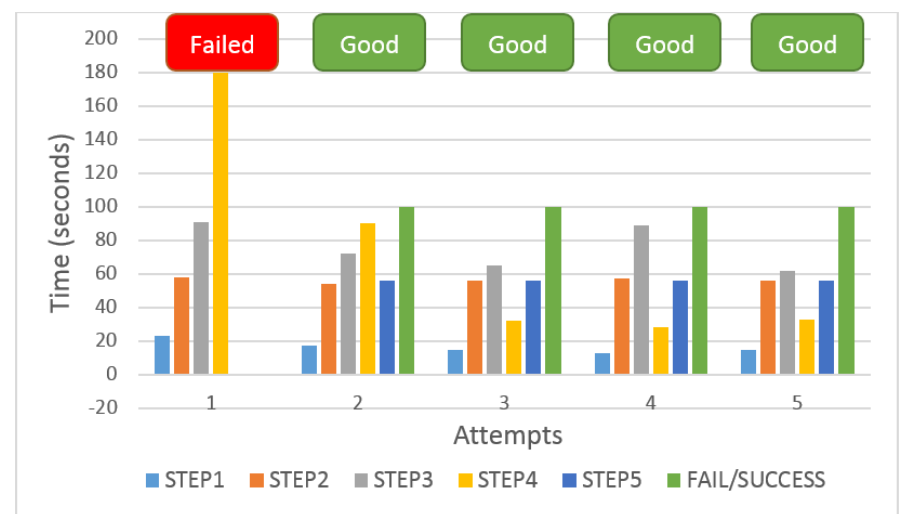
Figure 19. Usability test using 1 operator to control the team using cooperative behaviours: 1 experiment failed on grasping, and the following attempts were successful.